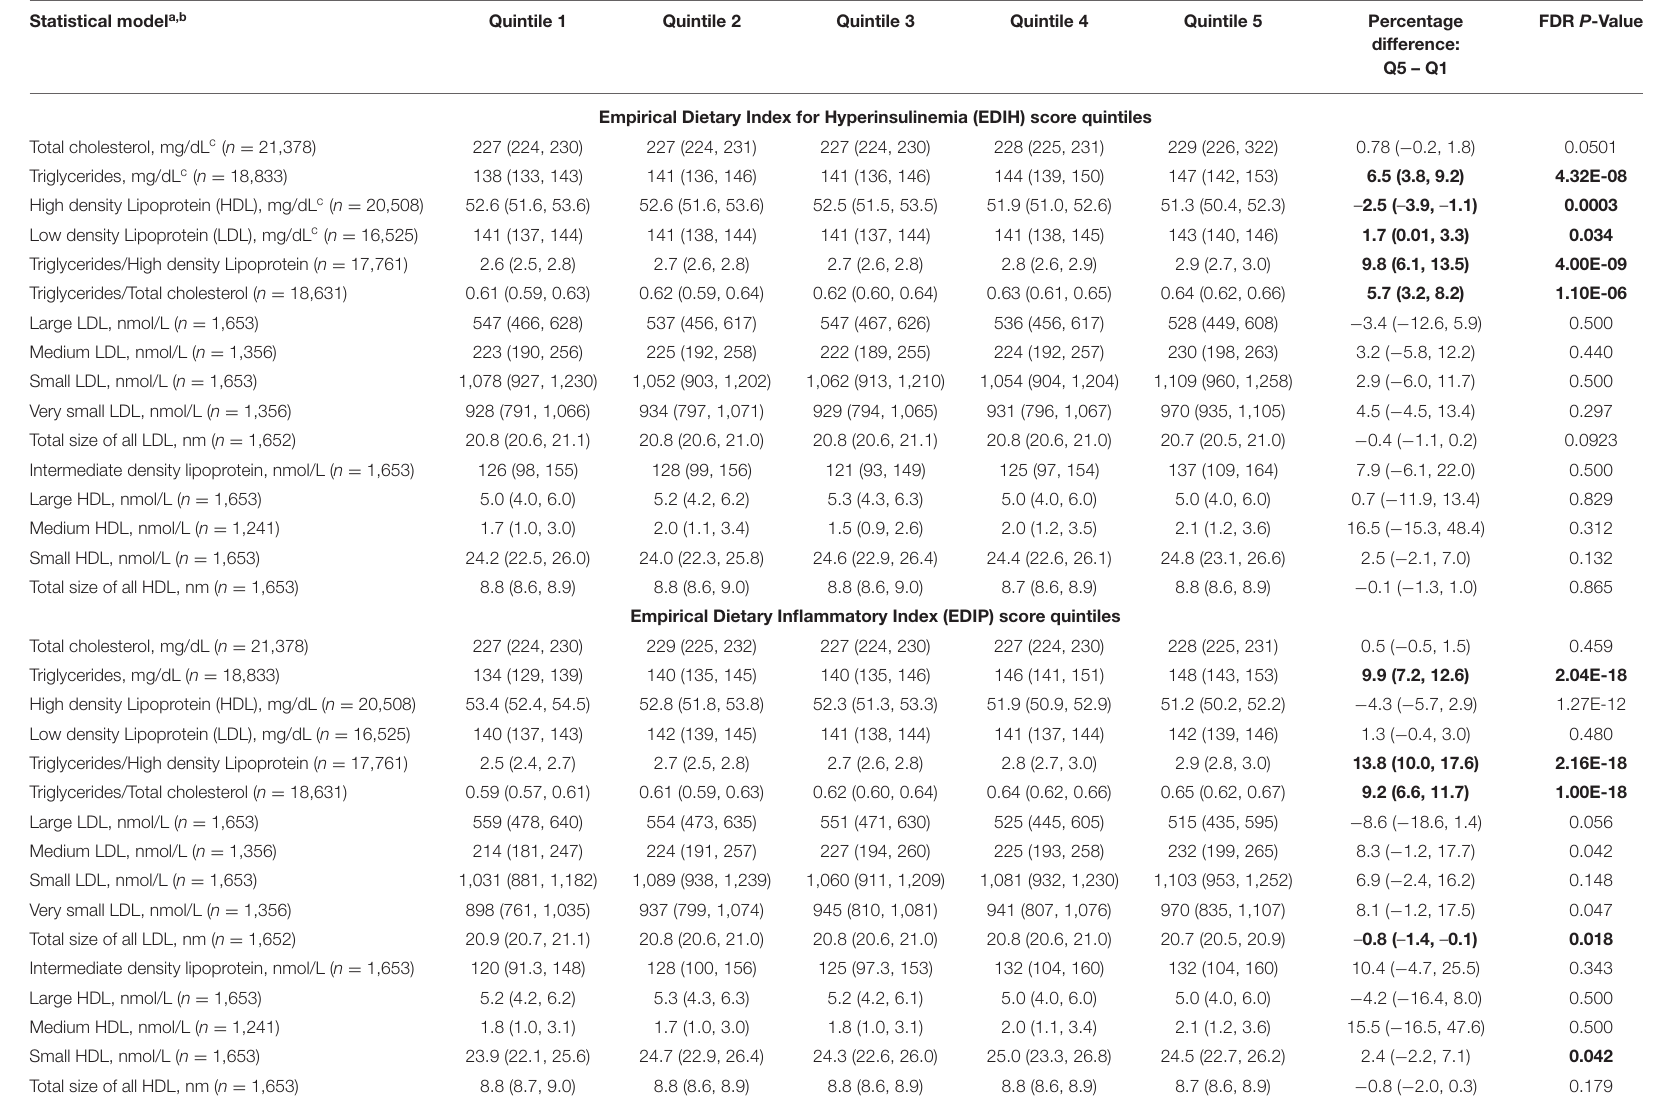
TABLE 5 | Multivariable-adjusted percent difference (95% CI) in the relative concentrations of circulating lipid and lipid particle biomarkers in quintiles of the dietary indices. Statistical model